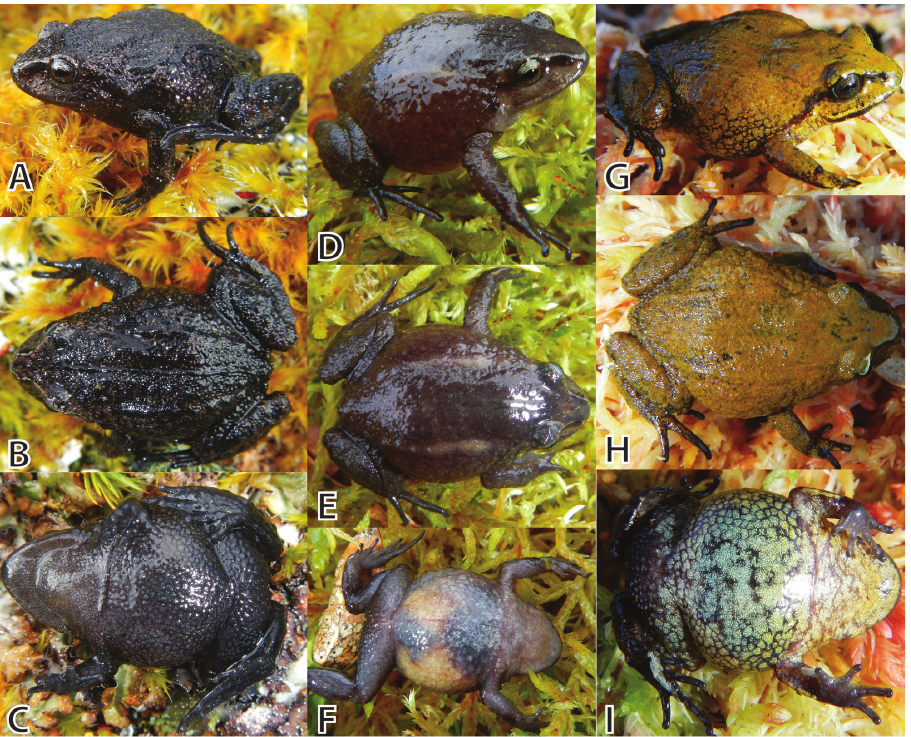
Figure 6. Variation of female paratypes of Pristimantis attenboroughi sp. n. in dorsolateral, dorsal, and ventral views. A–C (NMP6V 75522, SVL 19.2 mm) D–F (MUSM 31987, SVL 23.0 mm) G–I (MUSM 31977, SVL 21.9 mm). Photos by E.